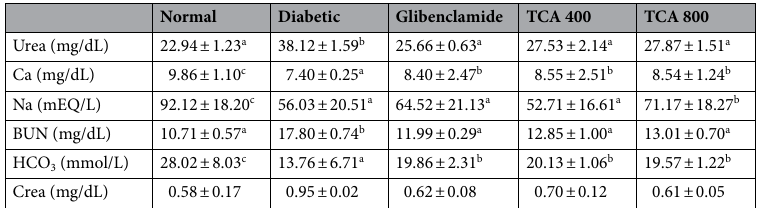
Table 2. Effect of T. catappa aqueous extract treatment on kidney function parameters in HFD/STZ-induced diabetic rats. Data are represented as mean ± SEM (n = 6). Values with different superscripts across a row are significantly different at p < 0.05. Values without superscripts across a row are not significantly different at p < 0.05. TCA: T. catappa aqueous extract ALT: alanine transaminase, AST: aspartate aminotransferase, ALP: alkaline phosphatase, ALB: albumin, BIL: bilirubin, Ca: calcium, Na: sodium, BUN: blood urea nitrogen,